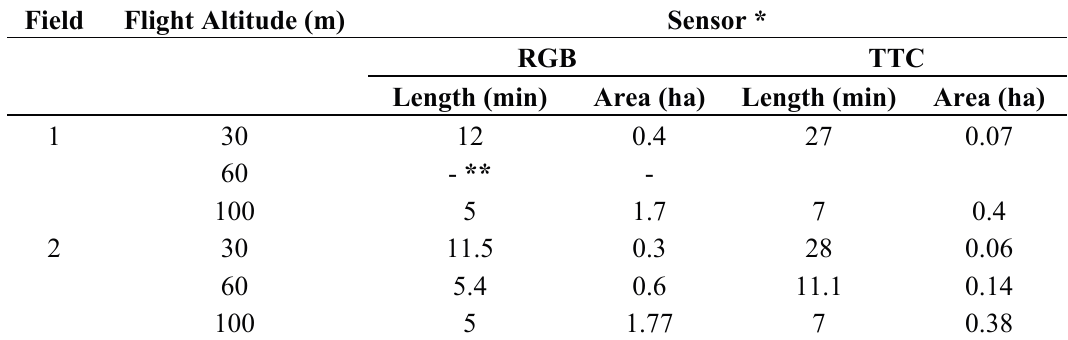
Table 1. Flight length and area flown over as affected by flight altitude and type of camera.